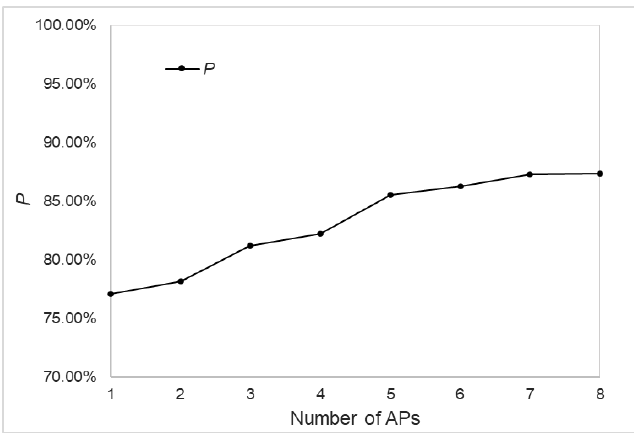
Figure 6. Error reduction ratio for the number of Wi-Fi APs.